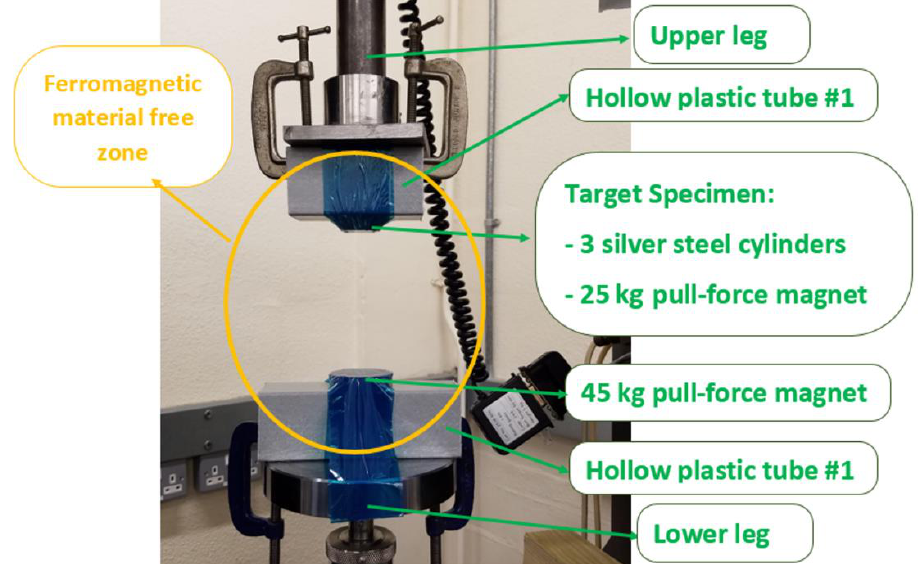
Figure 8. Experimental setup on the Instron machine testing the force curves as a function of dis- tance with three different shapes and sizes of silver steel and a 25 kg pull-force neodymium magnet as target specimen against a 45 kg pull-force neodymium magnet.